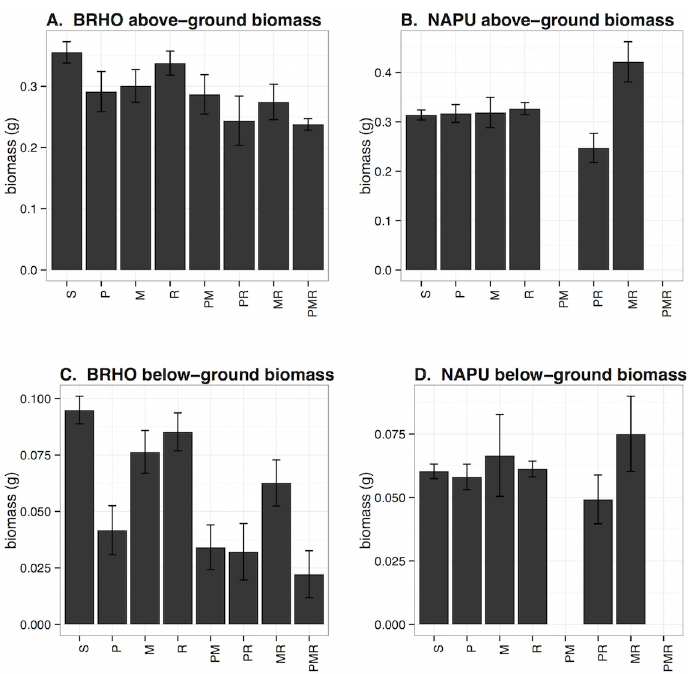
Fig 5. Biomass of plants in each infection class. A and B, above-ground biomass and C and D, below- ground biomass, both in grams. A and C are Bromus hordeaceus and B and D are Nassella pulchra . Infection classes are: S = susceptible, P = PAV only, M = MAV only, R = RPV only, PM = PAV-MAV, PR = PAV-RPV, MR = MAV-RPV, PMR = PAV-MAV-RPV. Data are from all plants in the experiment. Error bars are +/- 1 SE.